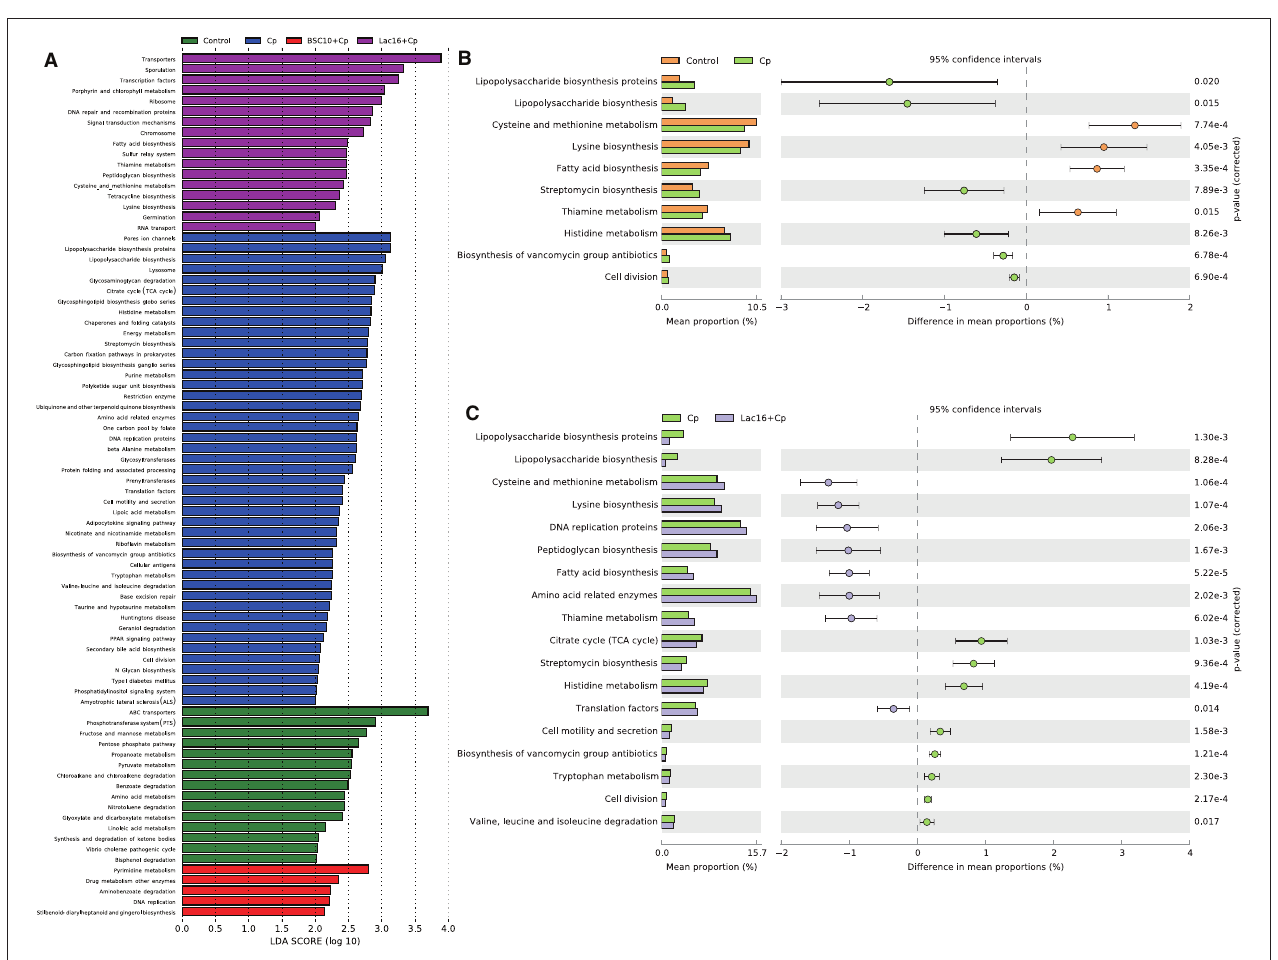
FIGURE 8 | (A) LEfSe analysis (LDA > 2., p < 0.01) of the microbial-predicted metabolic pathway functions at Level 3. (B,C) Comparison of predicted pathway abundances between the groups by statistical analysis of taxonomic and functional profiles ( STAMP ) at Level 3. (B) Control vs. Cp; (C) Cp vs. Lac16 + Cp.